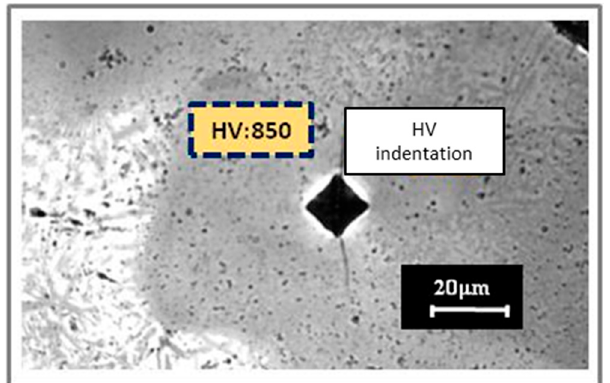
Figure 21. Indentation of the intermetallic layer.